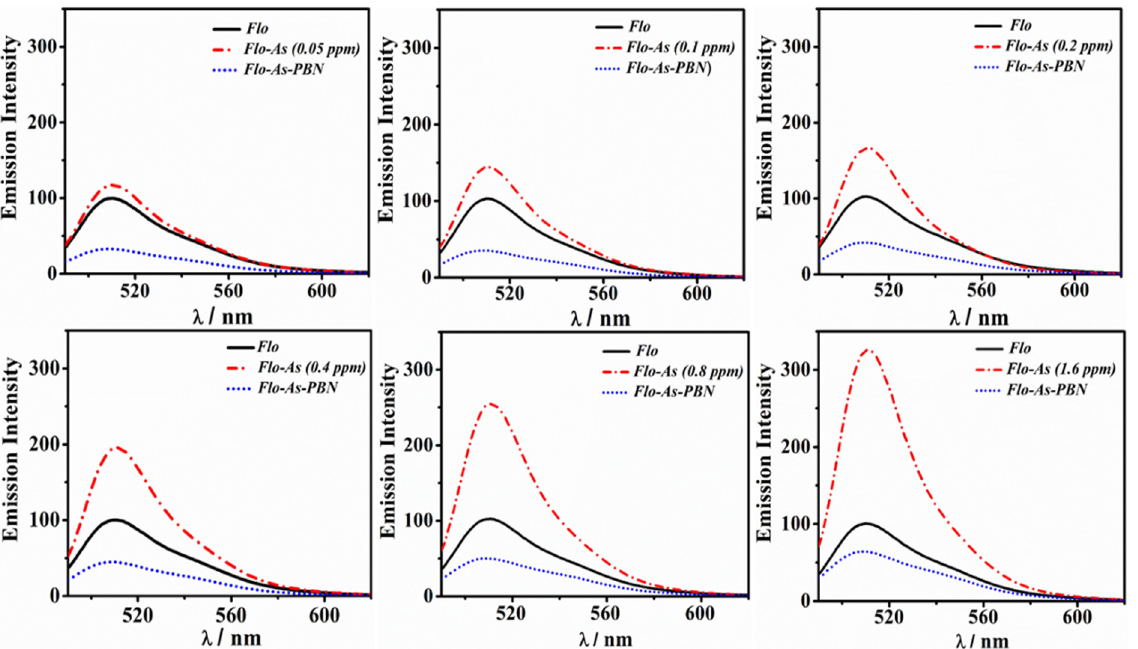
Figure 6. Study of the impact of PBN addition (10 − l ) over the emission intensity of Flo-As(III) system by varying the As(III) solution (0.05–1.6 ppm) and keeping a constant concentration of Flo (0.2 mM) and PBN (0.3 mM).